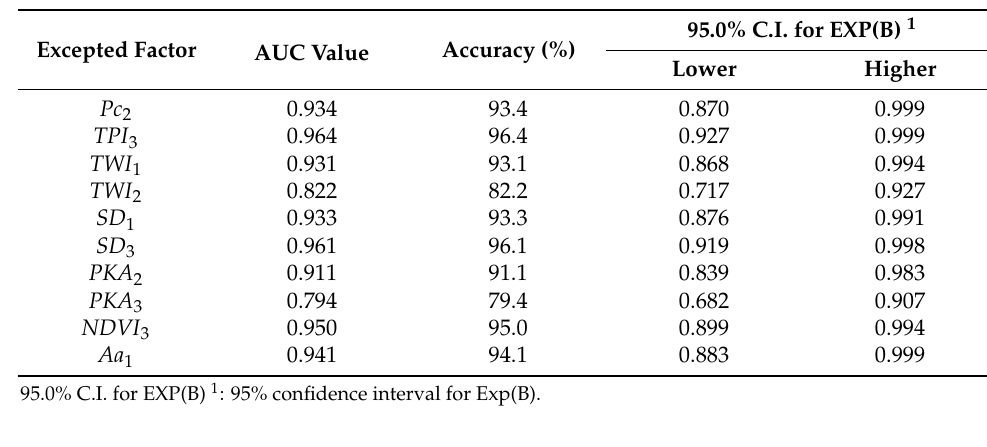
Table 6. The result of sensitivity analysis.